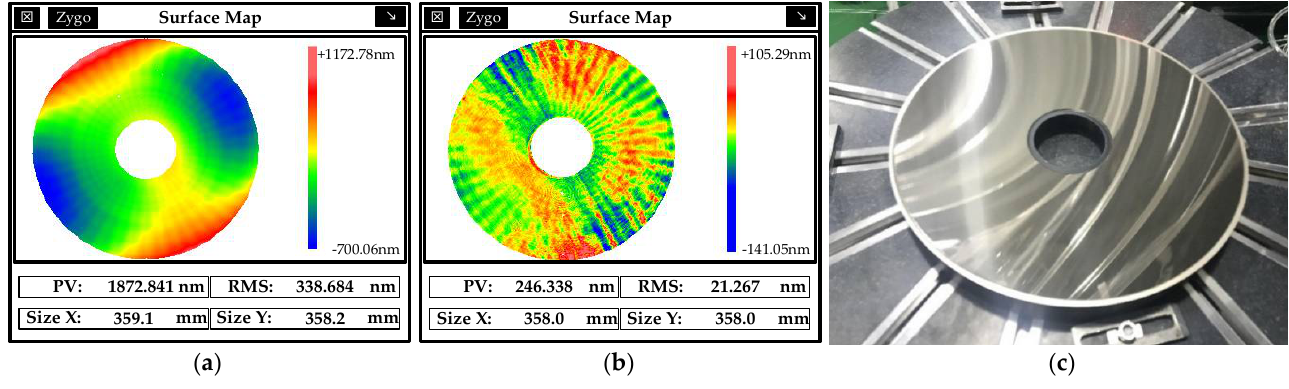
Figure 17. Results of paraboloid mirror before and after processing. ( a ) Before processing, ( b ) after processing, ( c ) physical processed mirror.